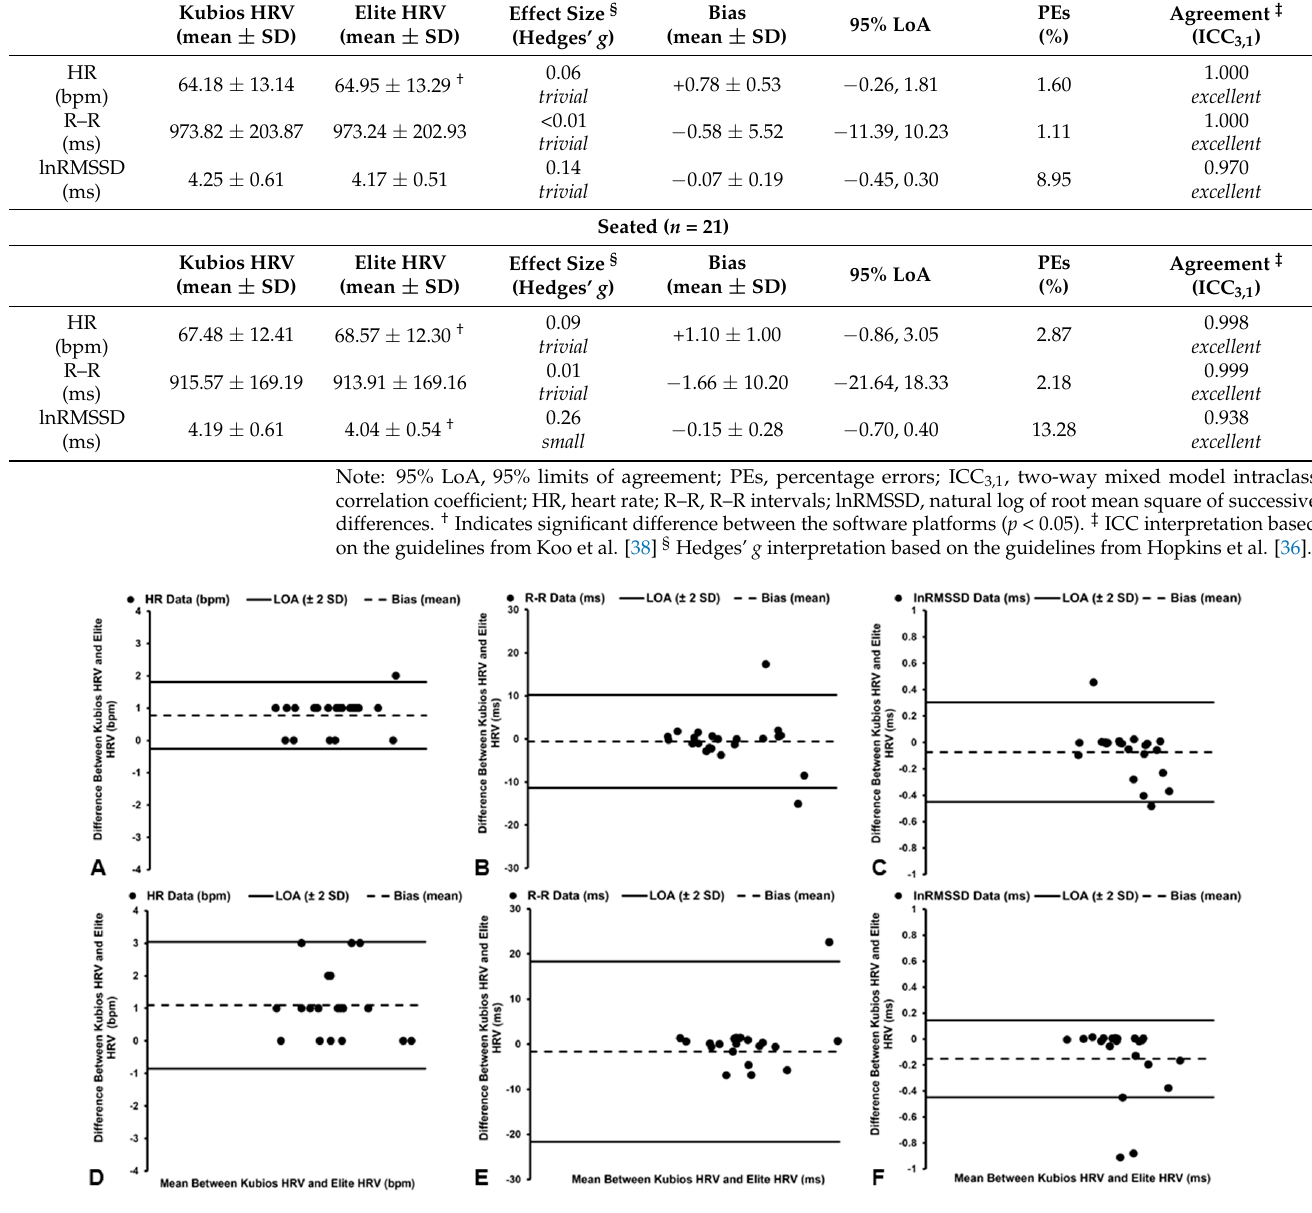
Trivial and nonsignificant ( t 21 = 0.494, p = 0.627) differences in R–R interval data were observed between the software platforms (Table 1), with a mean bias of − 0.58 ms and 1.11% PEs (Figure 2B). Excellent agreement (ICC 3,1 = 1.000, [95% CI: 1.000, 1.000]) and a near-perfect relationship were also identified between the software platforms ( r = 1.000, p < 0.001), with the Elite HRV smartphone application accounting for 100% of the variance ( R 2 = 1.00) in R–R interval data derived by Kubios HRV